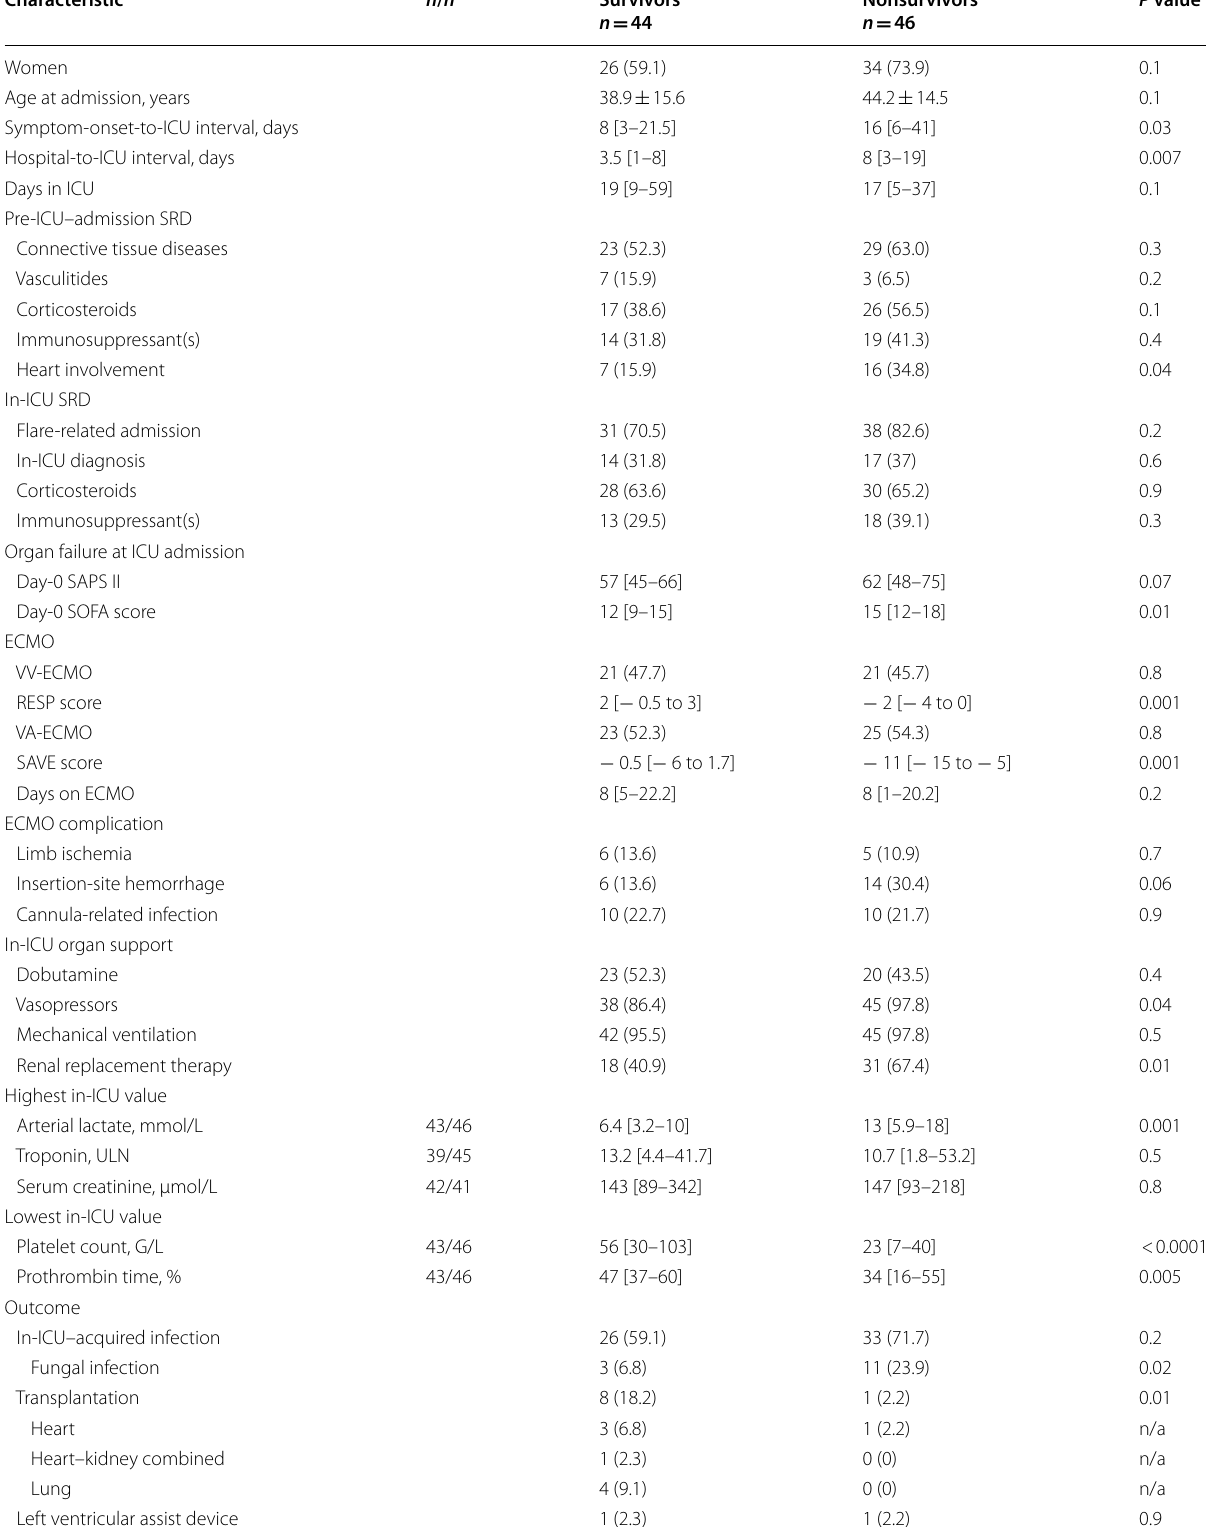
Table 2 In-ICU characteristics and outcomes of the 90 ECMO-treated SRD patients: hospital survivors vs.